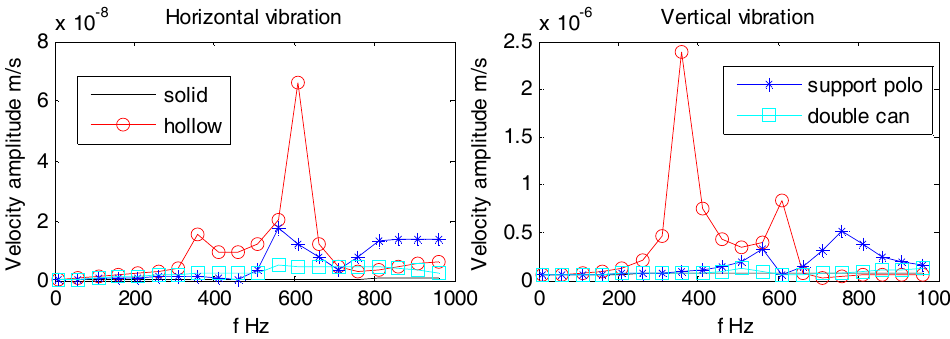
Figure 22. Vibration velocity amplitudes of OBSs with different compartments under incident 60°.